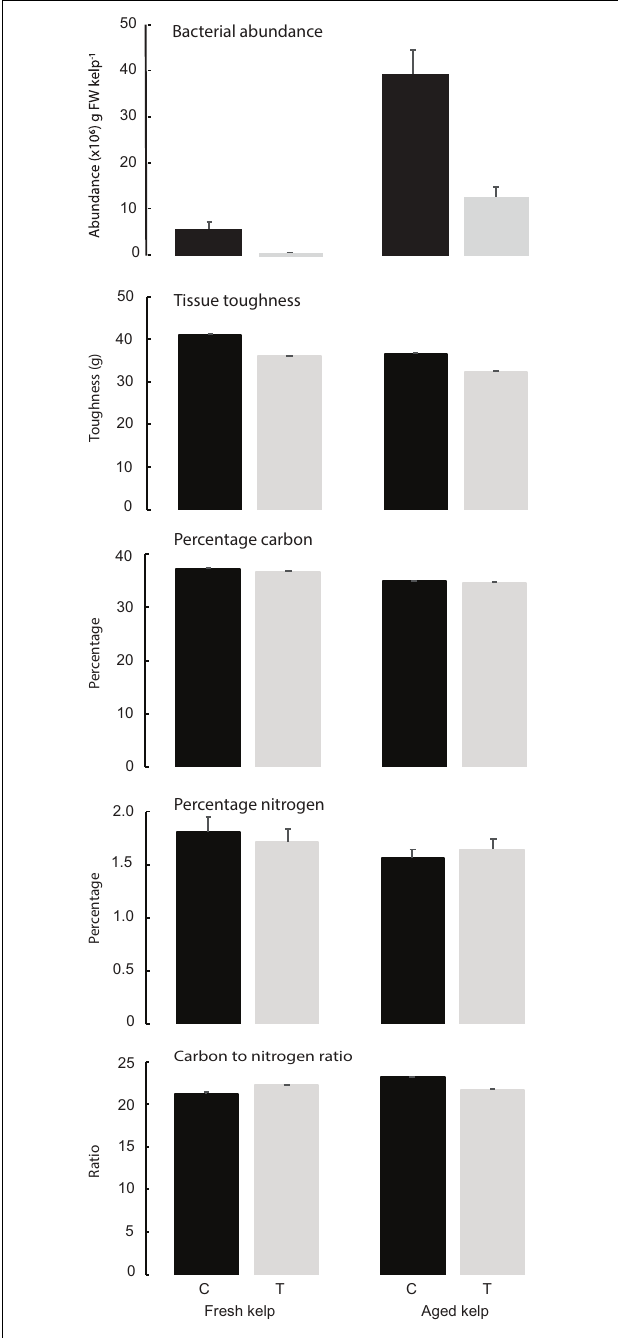
FIGURE 2 | Mean ( ± SE) bacterial abundance ( × 10 6 cells gFW − 1 ) on kelp, kelp tissue toughness ( g , n = 15), nitrogen content, carbon content, and C:N ratio ( n = 9) of kelp tissue in different kelp type (Fresh and 2 weeks Aged kelp) and treatment [Control (C) and Antibiotic treatment (T)]. Data for different times (Weeks 1, 4, and 8) were pooled since ANOVA showed no time